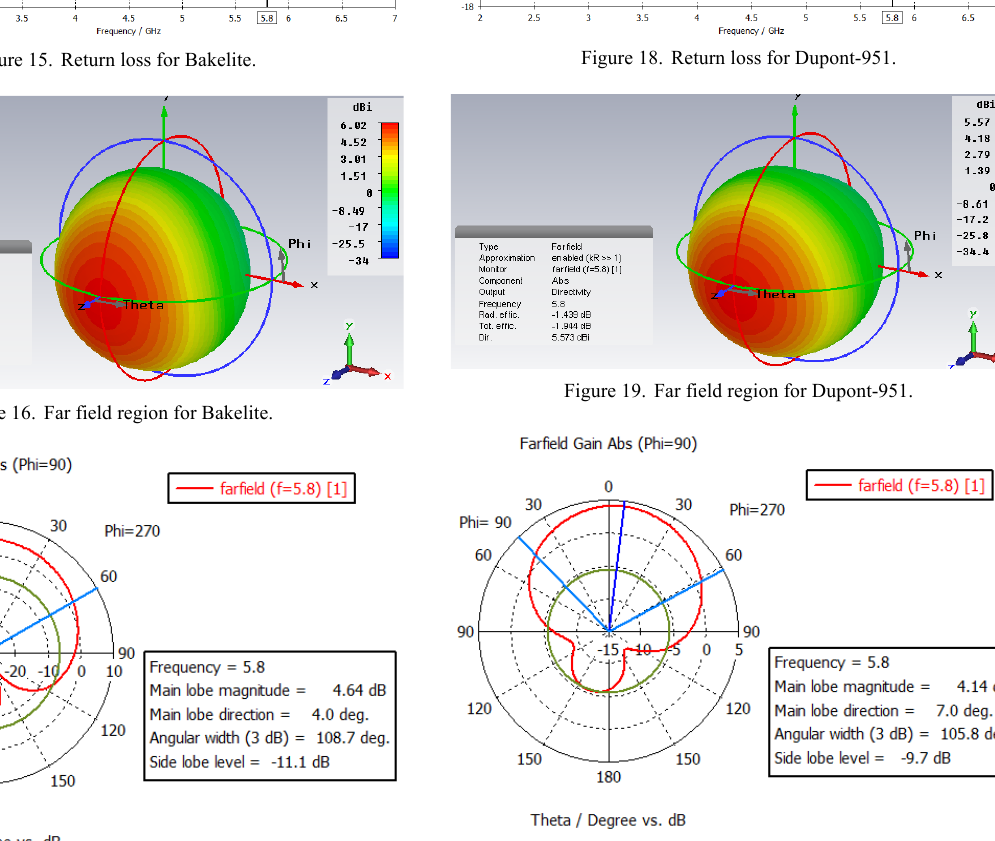
Figure 20. Far field polar view for